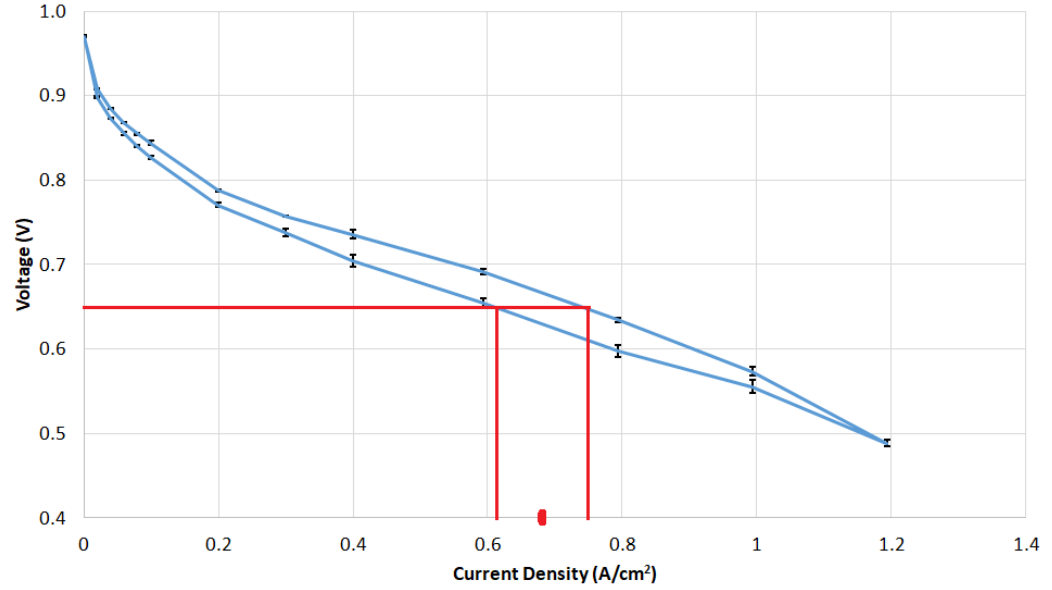
Figure B2. Method for identifying the 100% load in a polarization curve, as described in [11]. The 100% load value is obtained by averaging the two current values (in red) corresponding to the forward and backward curves (in blue) at 0.65 V.